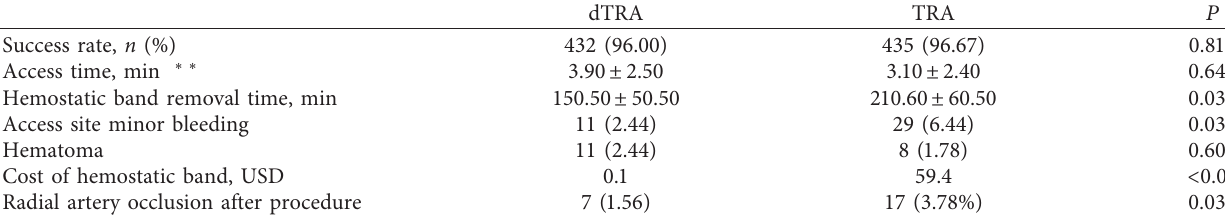
Figure 2: Success and failure of radial artery cannulation in the dTRA and TRA groups. The success rates were 96% (432/450) and 96.67% (435/450) in the dTRA and TRA groups, respectively ( P = 0.814). Table 2: Procedural and postprocedural characteristics of the dTRA and TRA groups ∗ .